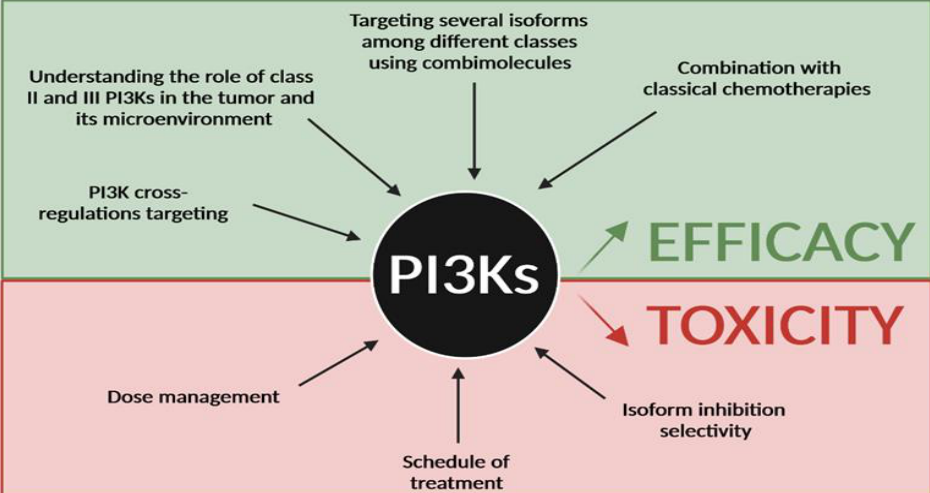
Figure 5. Future direction for PI3K targeting in cancer. Efforts have to be made to improve efficacy of PI3K inhibitors and reduce their toxicity in cancer treatment. Improving efficacy will require better knowledge of PI3K cross-regulations and the role of class II and III in cancer, to target several PI3K isoforms among the 3 classes and to combine existing PI3K inhibitors with classical chemotherapies. Reducing toxicity will go through a better dose management, different schedules of treatment and a better understanding of isoform specificity in organs and in cancer